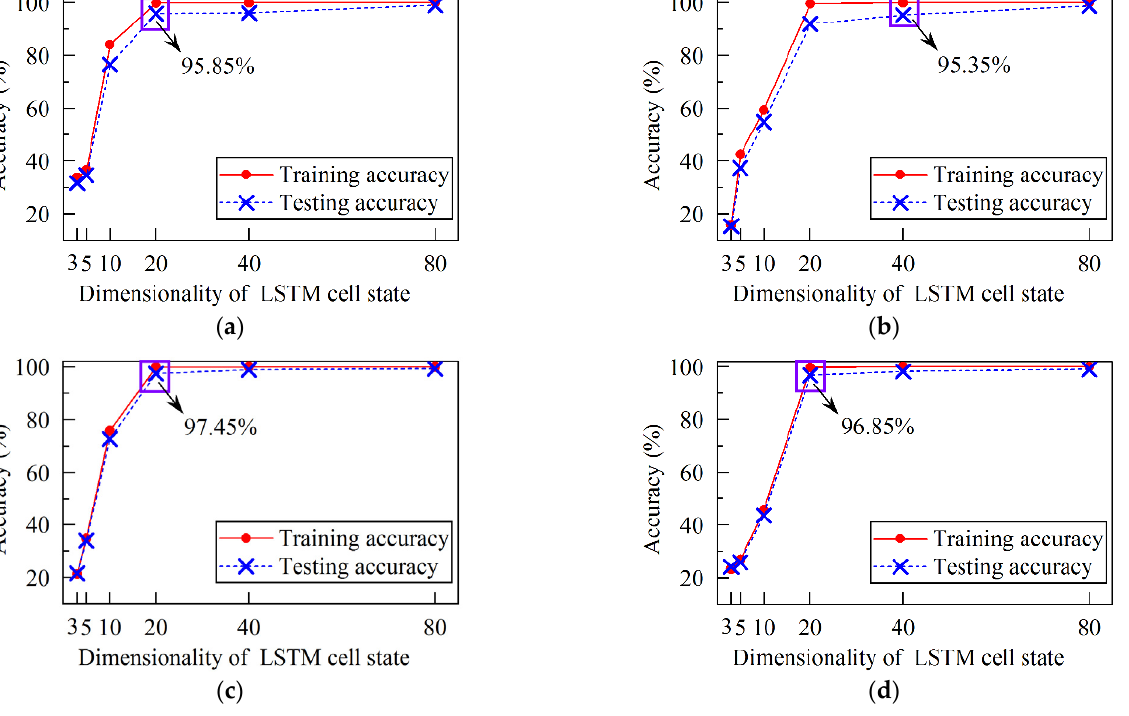
Figure 17. Training and testing accuracies of the fourth network structure. ( a ) Mode 2_a. ( b ) Mode 2_b. ( c ) Mode 2_c. ( d ) Mode 2_d. The purple circles mark the accuracies that are more than 95% with the lowest hidden element numbers.